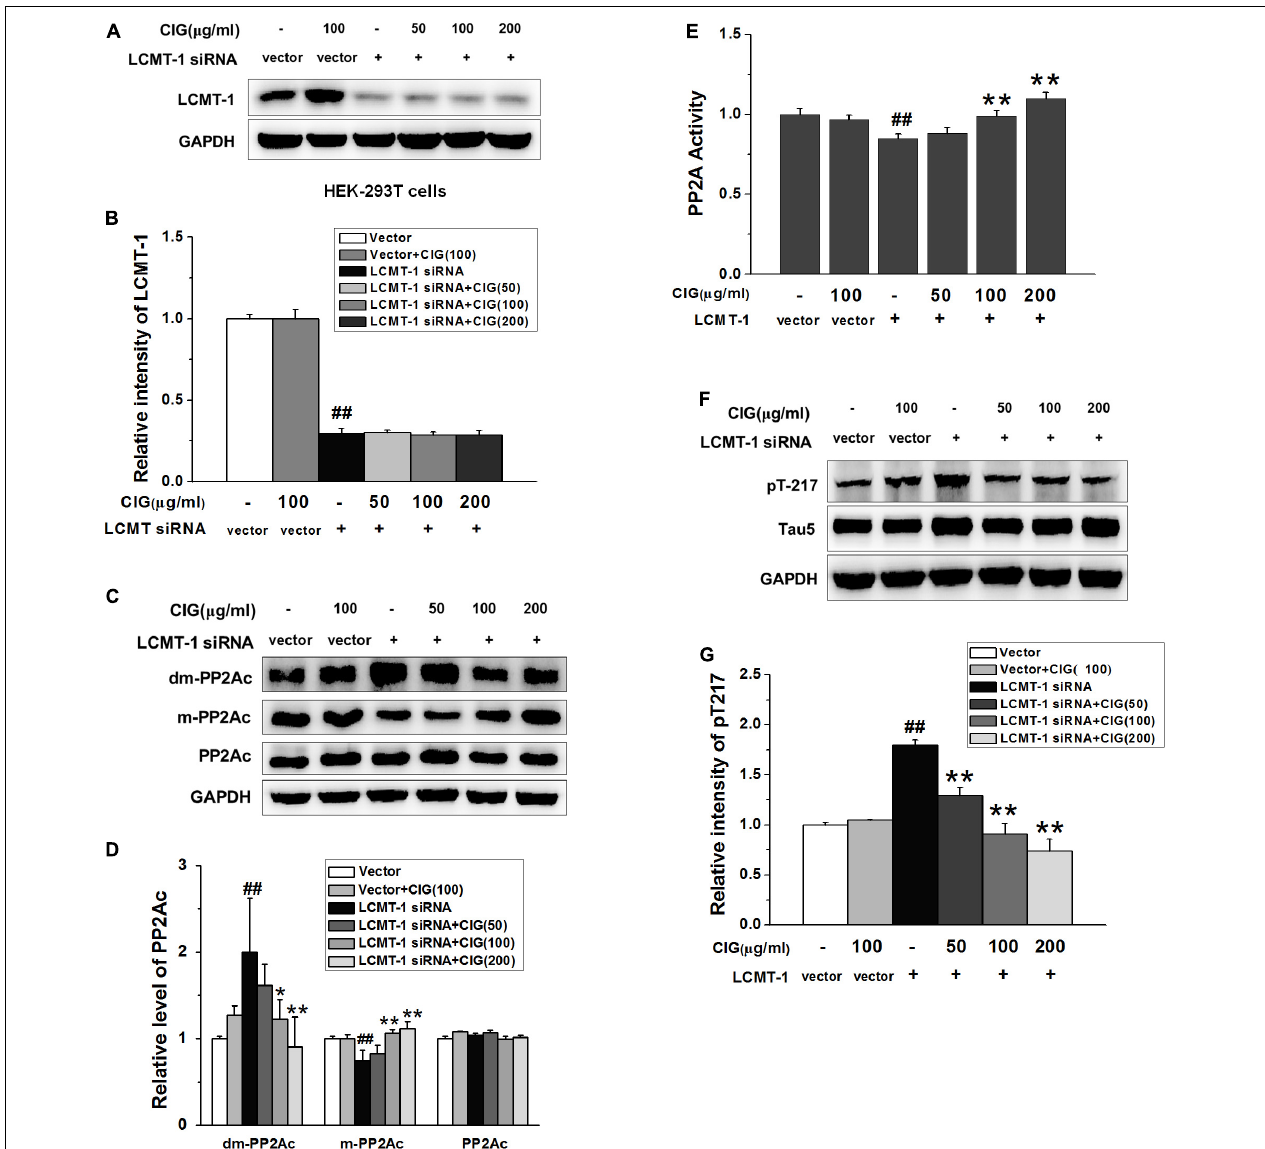
FIGURE 6 | Cornel iridoid glycoside inhibits demethylation of PP2Ac not entirely dependent on LCMT-1. (A,B) The expression of LCMT-1 in LCMT-1 siRNA-transfected HEK-293T cells detected by western blotting assay. CIG was incubated with the transfected cells for 24 h. (C,D) The expression of demethylated PP2Ac (dm-PP2Ac) and methylated PP2Ac (m-PP2Ac) in the transfected cells. (E) The activity of PP2A measured by a biochemical assay, n = 6 each group. (F,G) The phosphorylation of tau at Thr217 (pT217). GAPDH was used as an internal control, and the expression level of control group was set as 100%. Data represent mean ± SD; n = 3–4 each group. # P < 0.05, ## P < 0.01, the model group compared with the control group; ∗ P < 0.05, ∗∗ P < 0.01, drug groups compared with the model